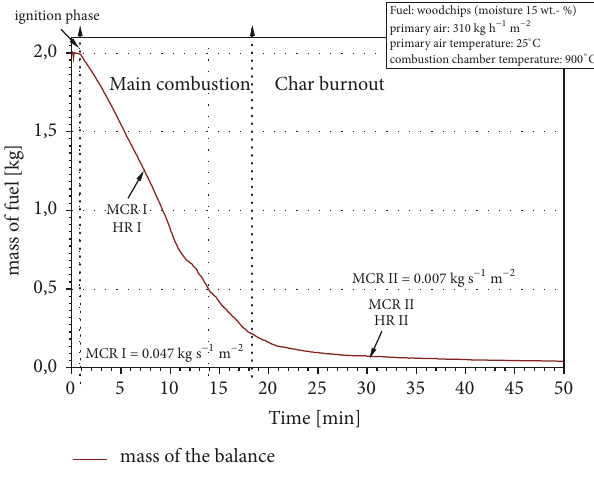
Figure 4: Mass decrease in the fuel bed